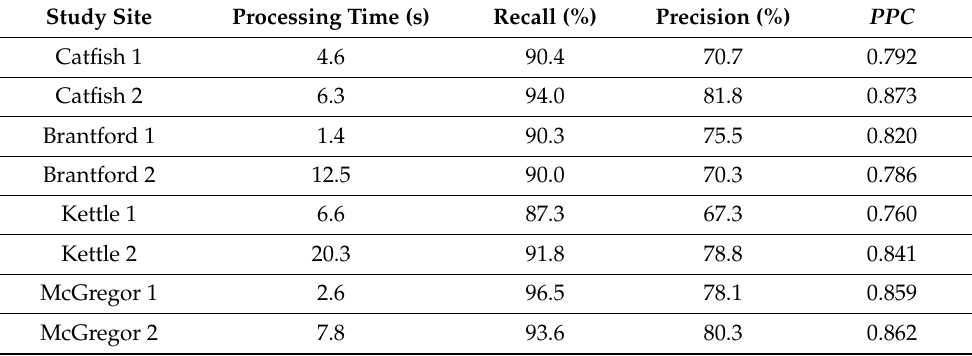
Table 4. Performance metrics of the embankment identification algorithm at each study site. Pro- cessing time was measured as the minimum processing time of 10 test runs and excludes data input and